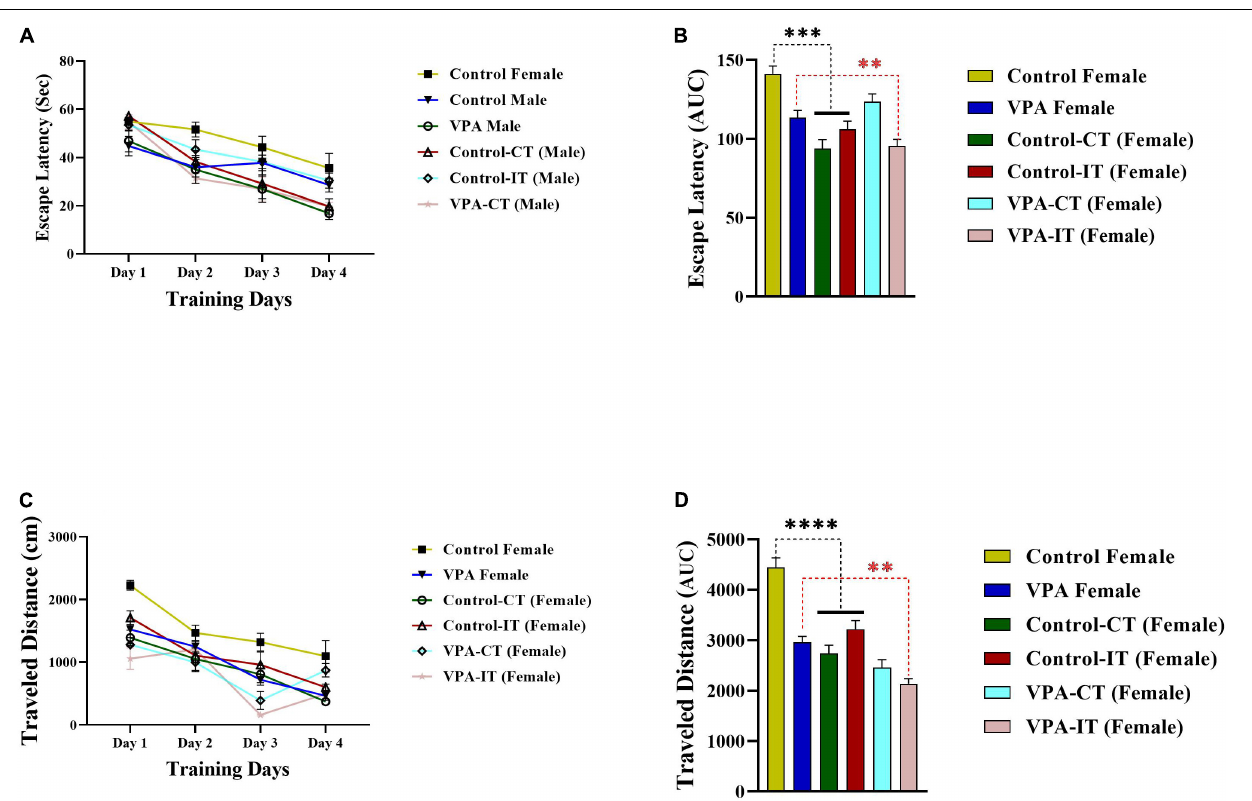
FIGURE 6 | The effects of IT or CT on the MWM acquisition in the control and VPA-exposed female offspring. Both IT and CT exercise trainings significantly reduced the escape latency (A) and traveled distance (C) in control female rats. IT exercise training (but not CT) reduced the escape latency and traveled distance in VPA-exposed female rats. AUC for escape latency (B) traveled distance (D) in female rats. Data are presented as mean ± SEM. ∗∗ p < 0.01, *** p < 0.001, ∗∗∗∗ p < 0.0001.